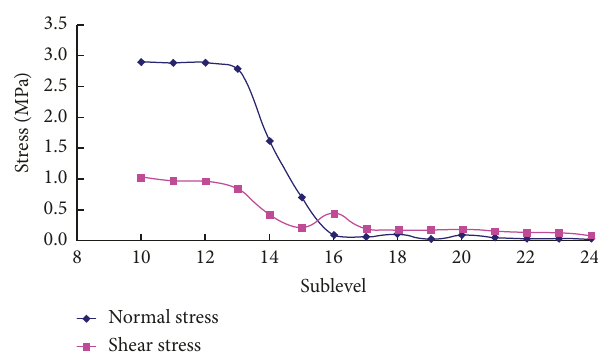
Figure 10: Relationship of stress state of fault F3 with mining